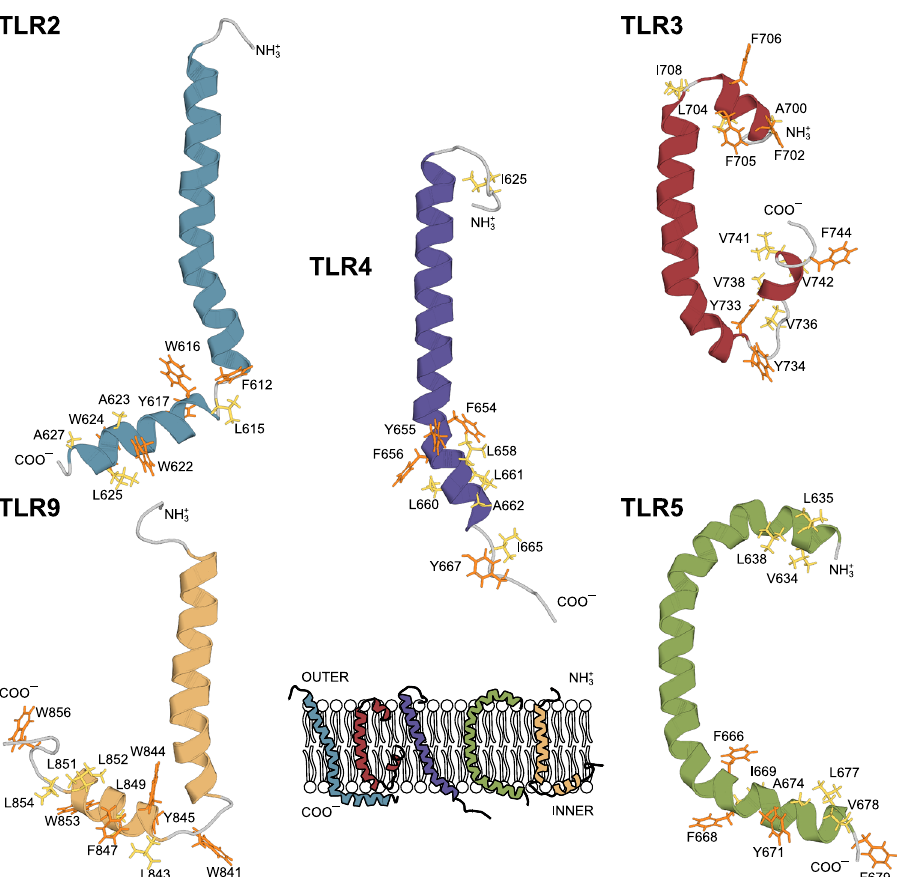
Fig. 3 | Spatial structures of TLR transmembrane domains with adjacent jux- tamembrane regions, as obtained in the current work. The structure of TLR4 is takenaccordingtotheworkbyMineevetal. 30 Bulkyhydrophobicandaromaticside